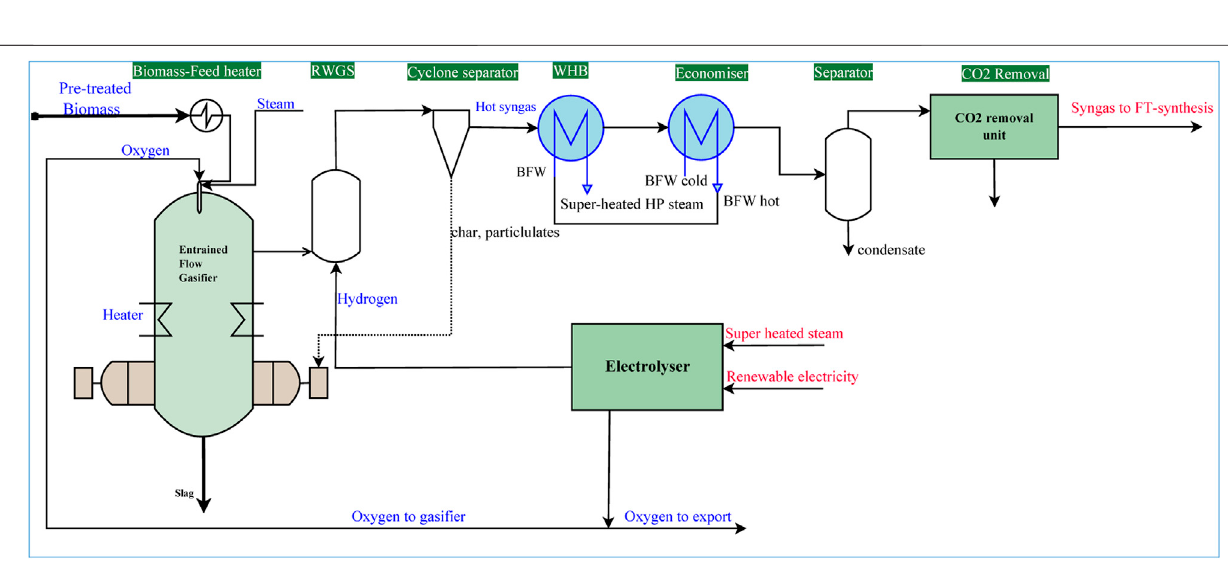
Figure 2 . Depending on the amount of energy added to the gasi fi er and the S/C carbon ratio, the CO 2 content in syngas varies. In the downstream Fischer – Tropsch synthesis, with a cobalt catalyst, CO 2 is inert and does not participate in the reactions. Hence, CO 2 removal is essential to optimize the reactor size and thereby costs associated with the FT